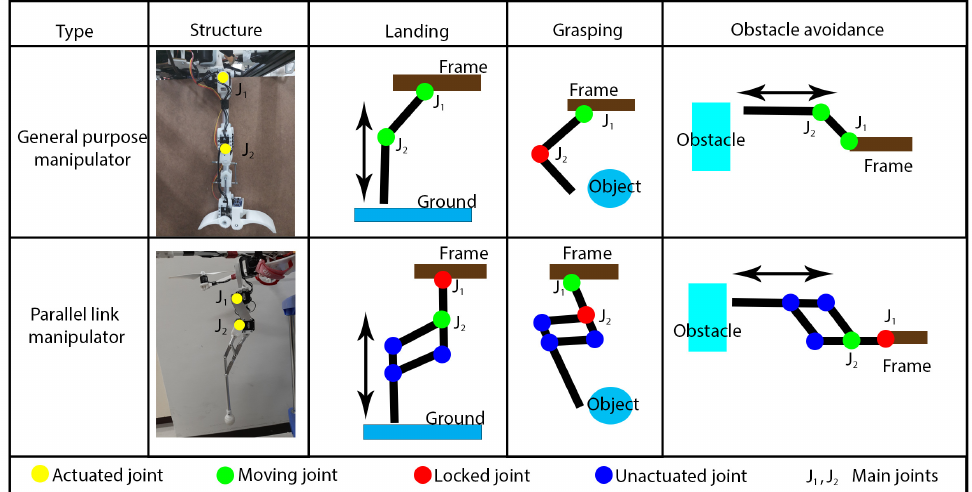
Figure 2. General-purpose manipulator and parallel link manipulator design comparison for different